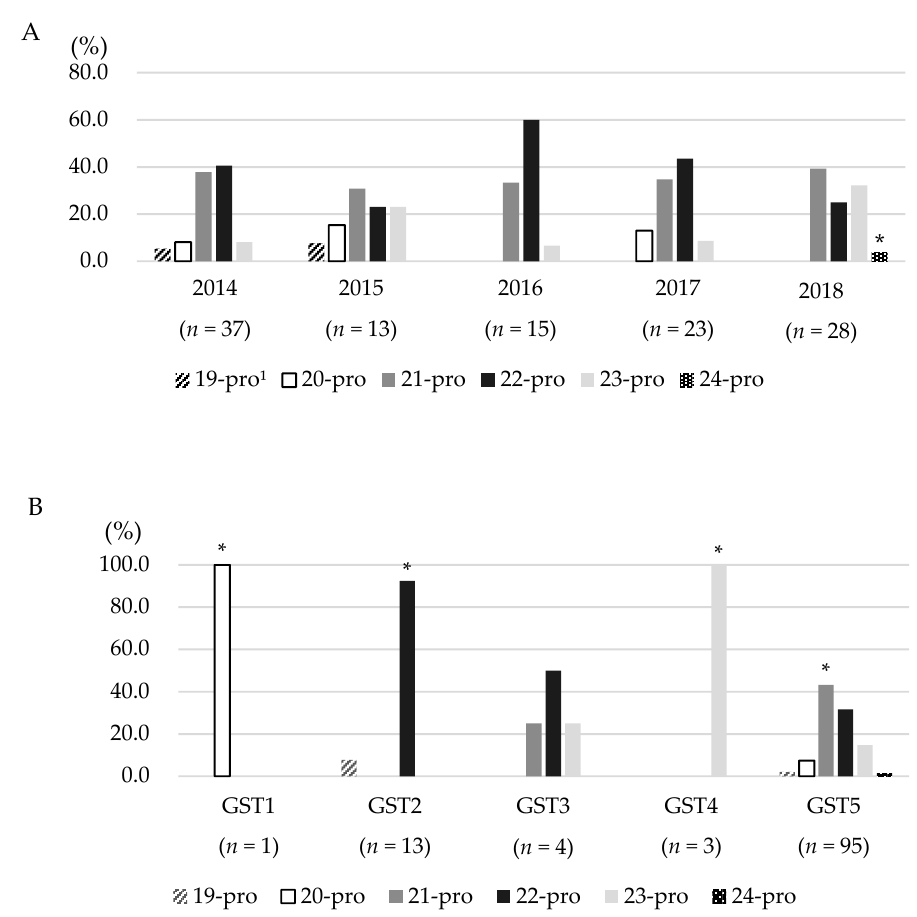
Figure 3. Bar graphs of polyproline linker (PPL) lengths percentage of Salmonella Gallinarum isolates. The graph represents PPL length variation from 2014 to 2018 ( A ) and according to GST ( B ). ¹ The number of prolines in PPL region of SpvB. * p < 0.05.